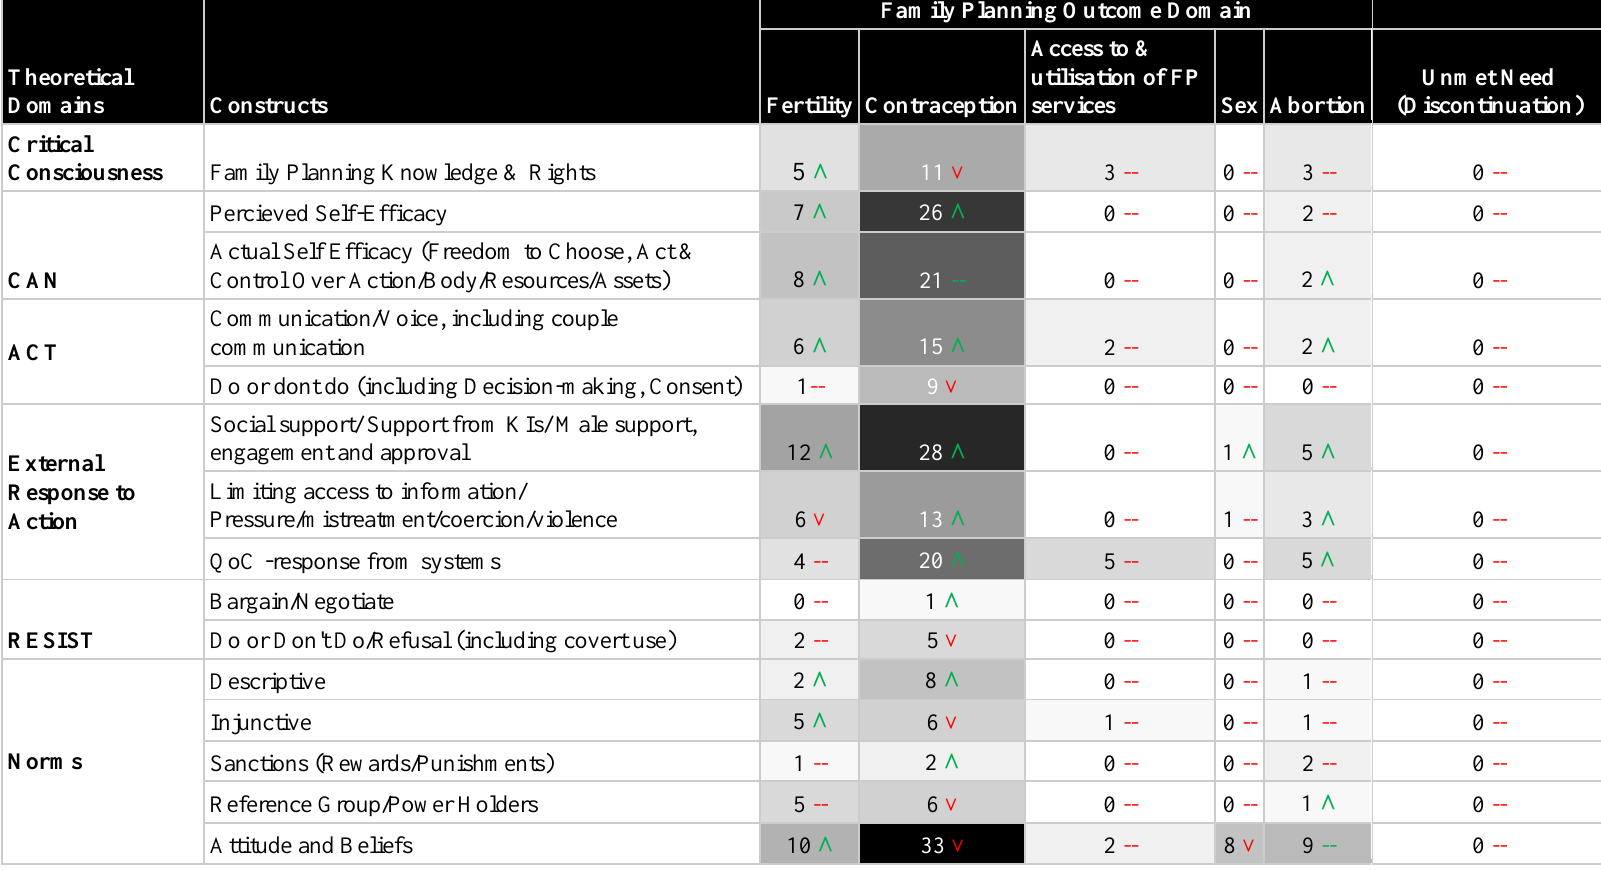
Table 3: Heat Map of Measures from the Published Literature (2010-2021) on Gender Equity in Family Planning (n=223